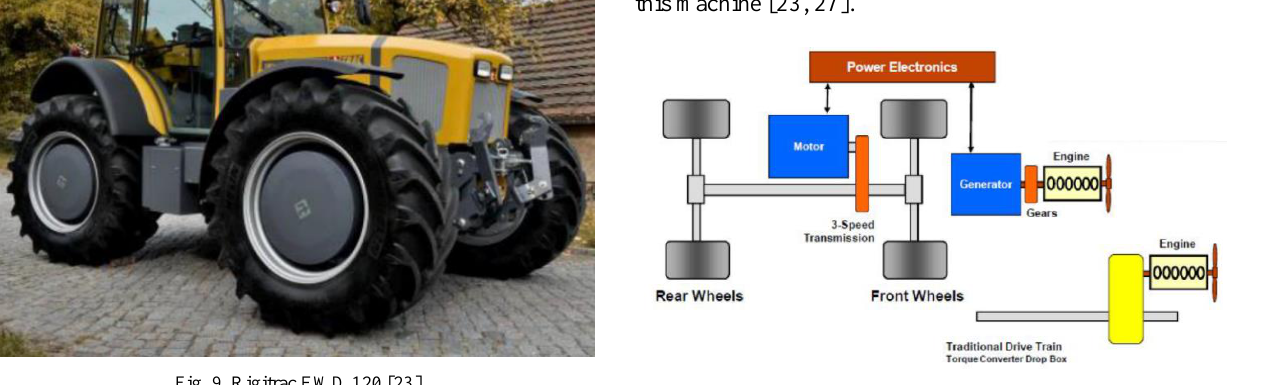
Fig. 12. John Deere 644K loader powertrain diagram, hybrid and tradition- nal